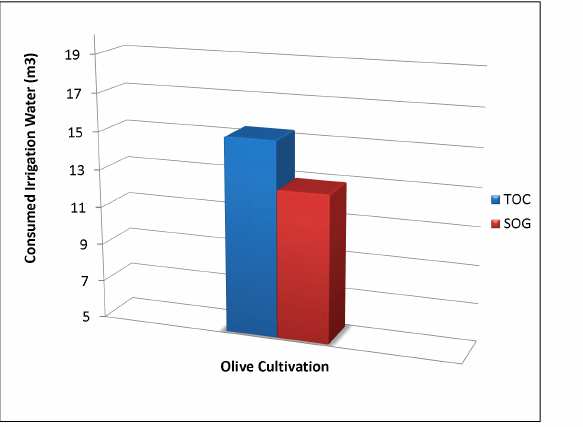
Figure 10. The amount of irrigation water of the proposed SOG and